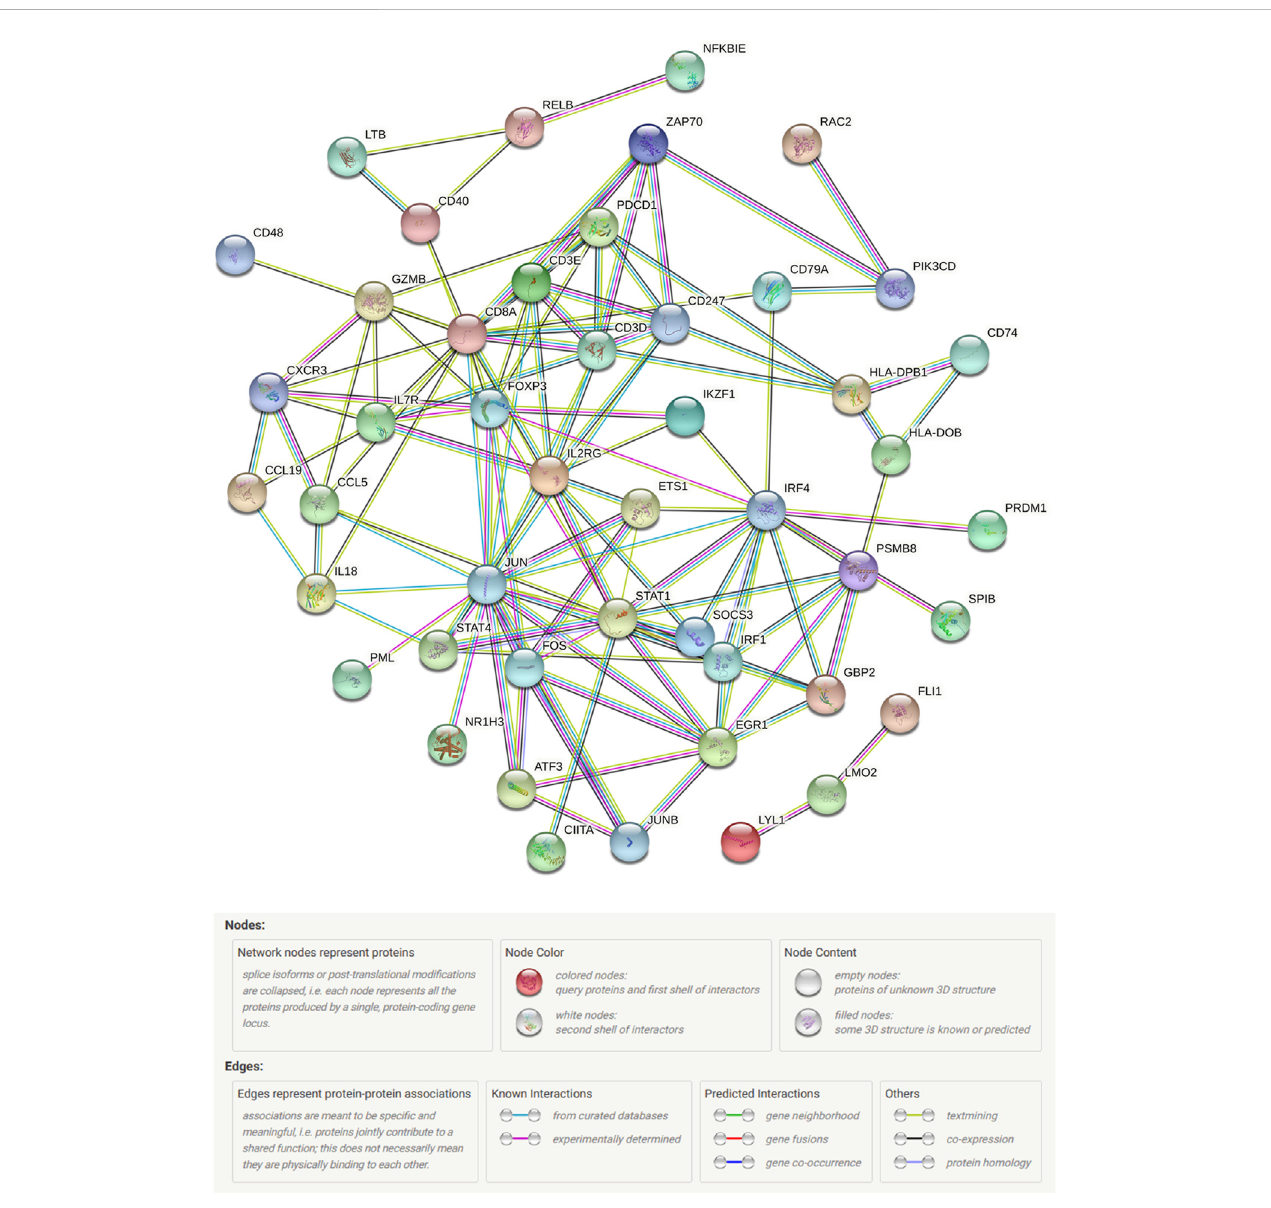
FIGURE 6 STRING protein – protein interaction network connectivity for prognostic immune-related genes and transcription